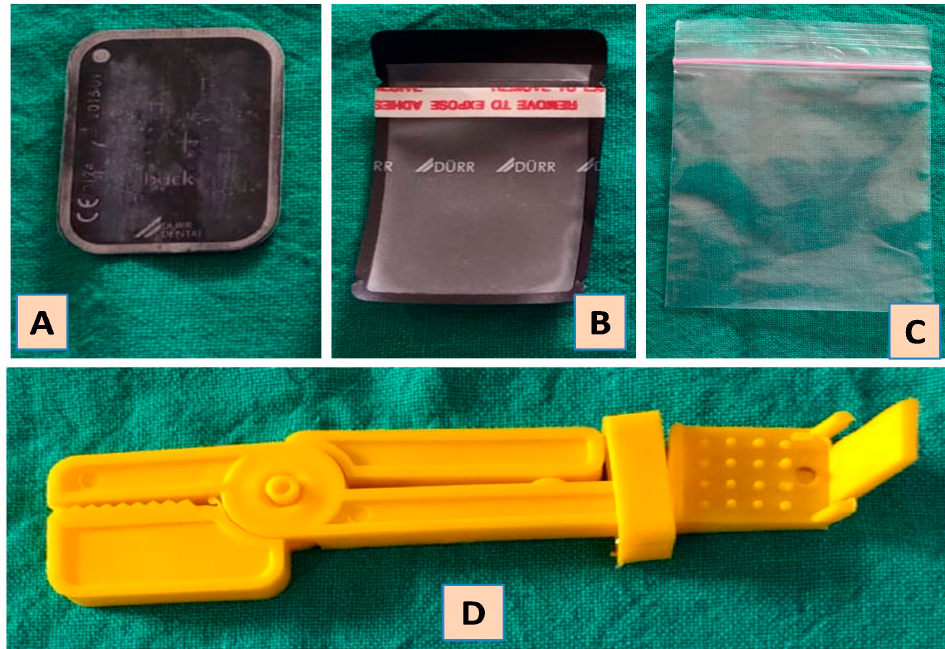
Figure 3. Intra oral radiography films and accessories. ( A ) Phosphor Storage Plates (Sensor); ( B ) Disposable sleeve for the sensor; ( C ) Outer (double barrier) transparent disposable sleeve for the sensor; ( D ) Eezee Grip / Snap A Ray Film holder for intra oral radiography.